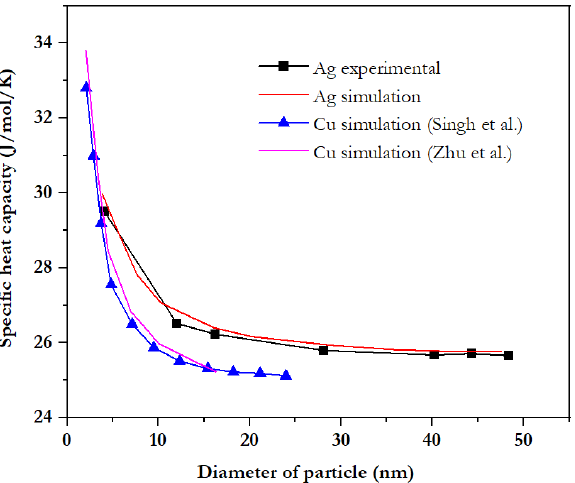
Figure 5. Variation of specific heat capacity with particle diameter of Ag [32] and Cu [7,34,35]. Singh et al. [32] extended the study by including the shape effect from nanoparticles, nanowires, and thin film, on the surface energy. In Equation (19), η s /2 n is further defined by the 2 d a / D for spherical nano solids, where D is the diameter of spheric nanosolid and d a is the atomic diameter. For nanofilm and nanowires, the values of η s /2 n are expressed as 2 d a /3 d and 4 d a /3 I respectively, where d is the width of nanofilm and I is nanowire diameter. They performed model prediction in In and Se, as shown in the Figure 6 [32], and compared the result with the experimentally observed heat capacity of Ag nanosolids [35]. One can conclude that heat capacity increases with a decrease in the size as well as shapes in the following way: nanoparticles > nanowires > thin film.